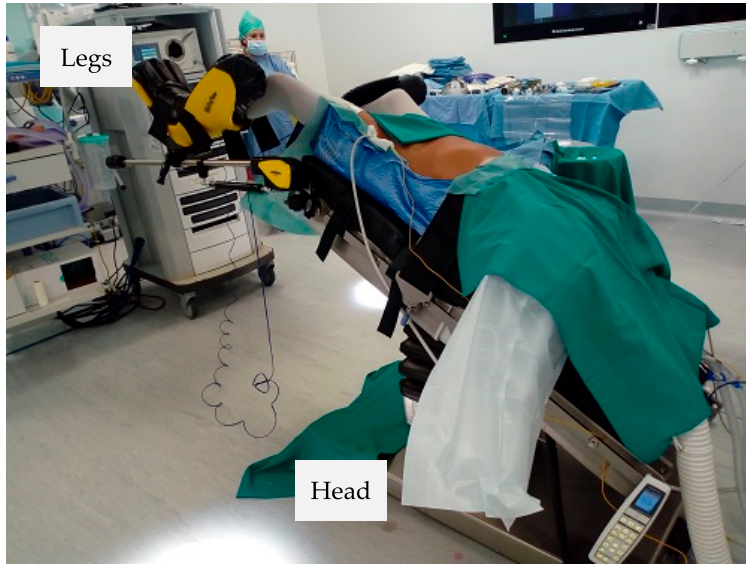
Figure 2. Patient positioning.